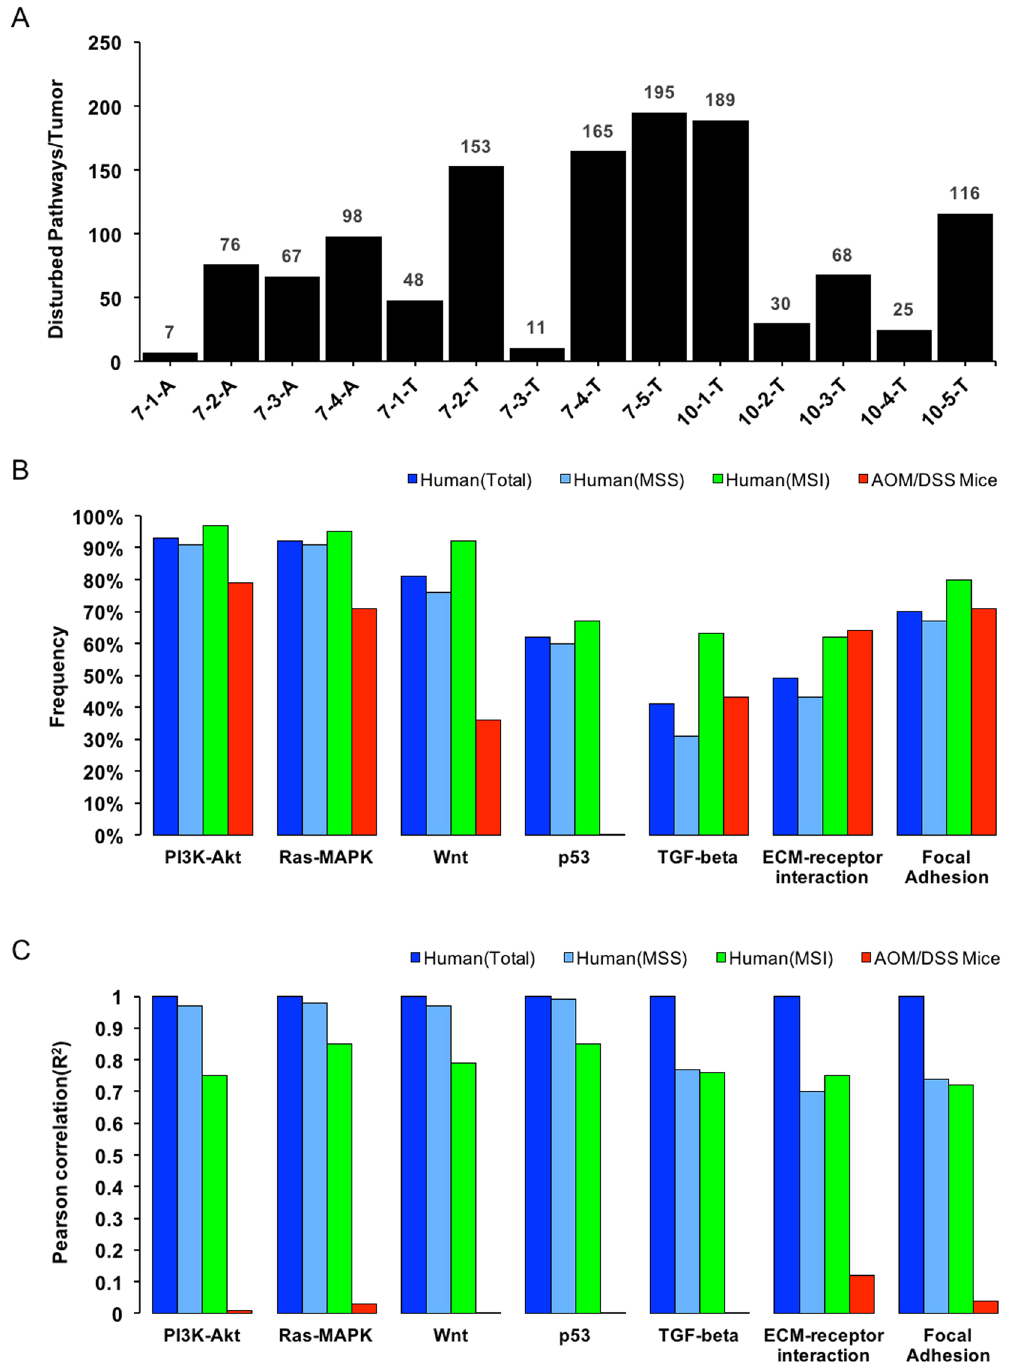
Figure 5. Landscape of disturbed pathways in AOM/DSS mouse model and its comparisons with Human CRC. ( A ) Number of disturbed pathways in each of 14 neoplastic samples is indicated with bar plot. Comparisons of five key pathways in human CRC and two most enriched pathways in AOM/DSS mouse model among three groups of human CRC and AOM/DSS mice in their frequencies ( B ) and patterns of damaging genes involved ( C ). In Fig. 5C, shown are bar graphs of Pearson correlation (R 2 ) for the seven pathways. The groups of total Human CRC cases is shown as the